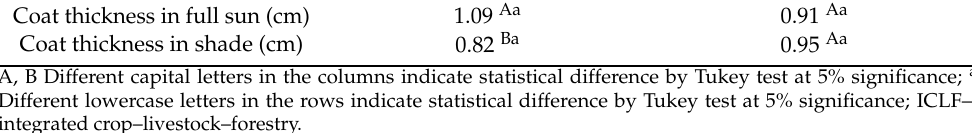
Table 2. Average length of the 10 longest hairs, number of hairs per cm 2 , and skin and coat color (Silva, 2000) of Gyr and Girolando cows in full sun and ICLF shade production systems. Parameter Full Sun Shade p -Value * Gyr